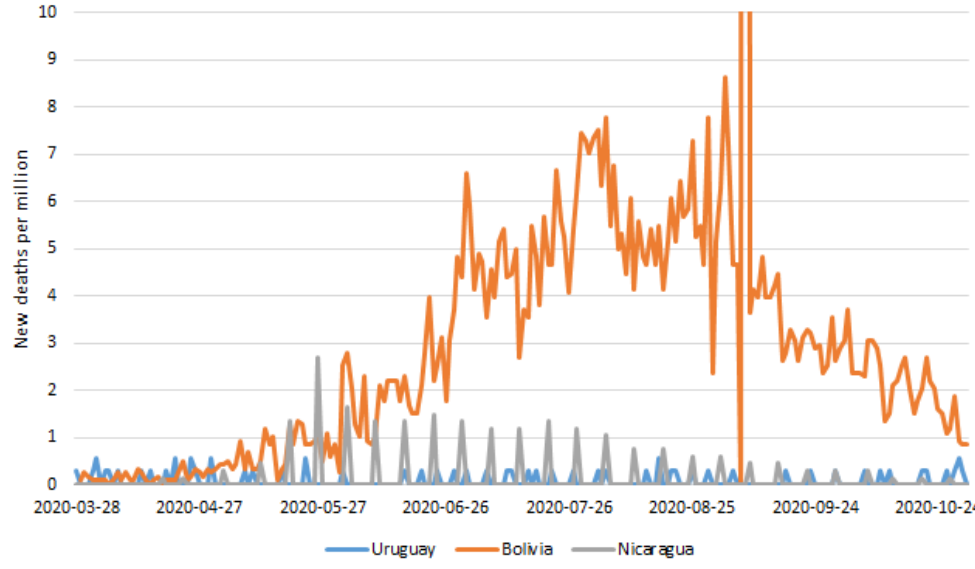
Figure A2. COVID-19 new deaths per million inhabitants, Bolivia, Nicaragua, and Uruguay, March to December 2020.